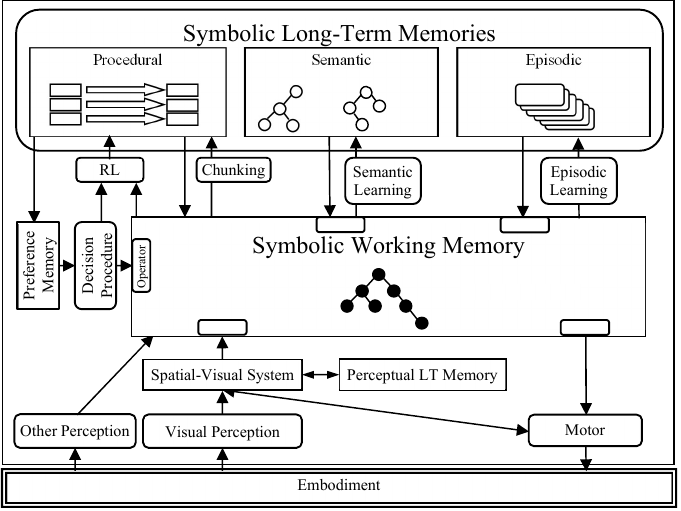
Figure 1. The structure of Soar memories, processing modules, learning modules and their connec- tions. Reproduced from [7] (Figure 1), with permission from John